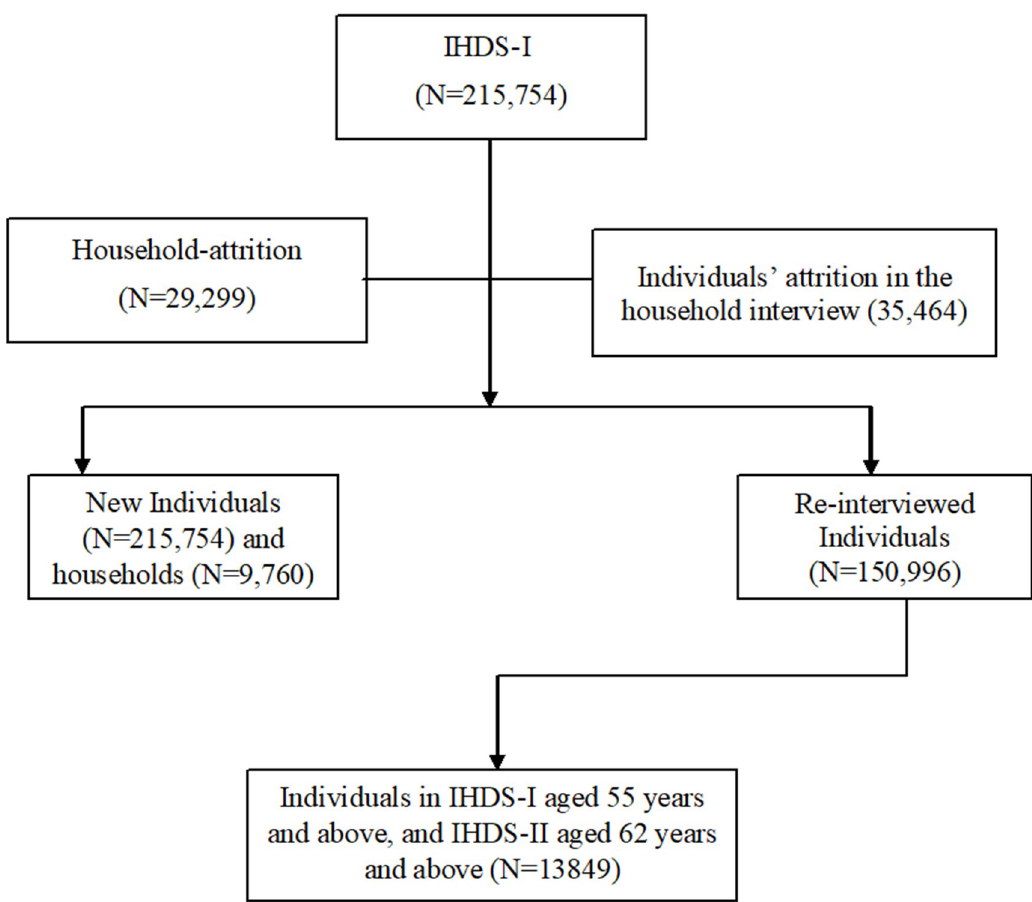
Fig 1. Flow chart of the sample selection in the study. Sources: The authors referred the IHDS website and the IHDS merging guide.